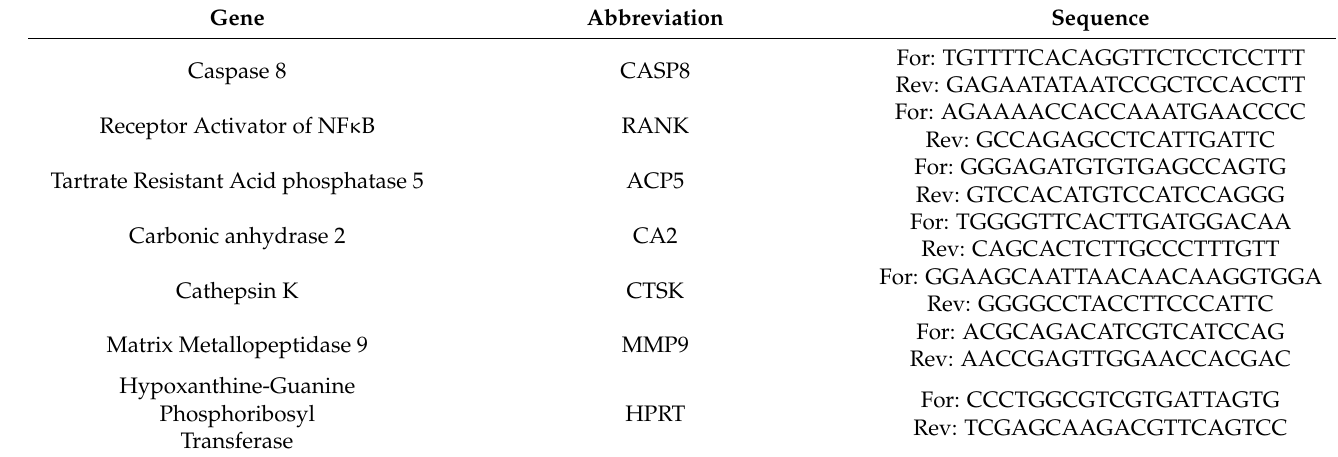
Table 1. Primer sequences for the genes of